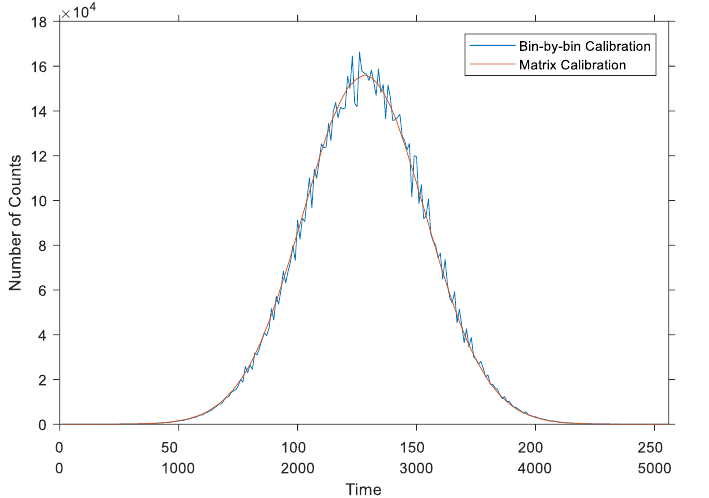
Figure 17. Calibrated histogram of a Gaussian signal — asynchronous TDCs.